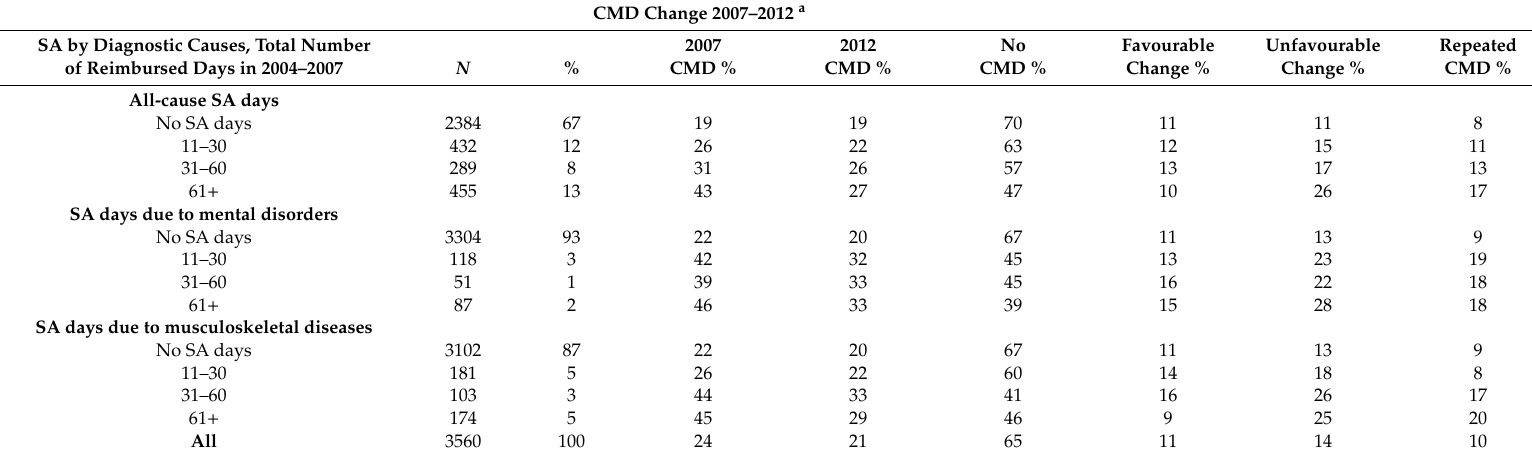
a Favourable change = CMD in 2007 only. Unfavourable change = CMD in 2012 only. Repeated CMD = CMD in both 2007 and